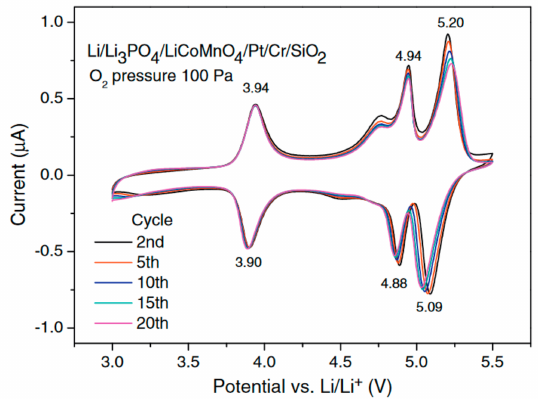
Figure 10. Cyclic voltammogram recorded at a 0.5 mV · s − 1 scan rate of a Li / Li 3 PO 4 / LiCoMnO 4 thin film battery. The LiCoMnO 4 film cathode was grown under P O from [171]. Copyright 2014